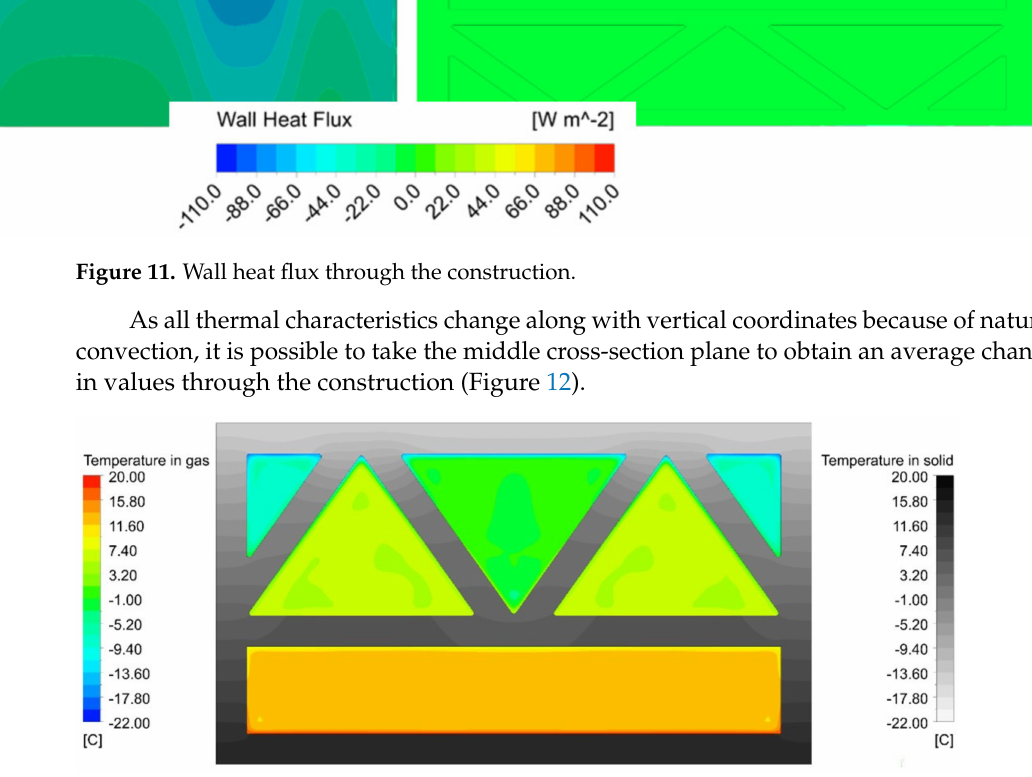
Figure 12. Temperature field on the middle cross-section plane of the construction. There is one rectangular cavity, two hot triangle cavities, and three cold rectangular cavities. All cavities except small triangle ones seem to have stabilizing effects on concrete temperature. Noticeable differences in temperature in air persist only in boundary